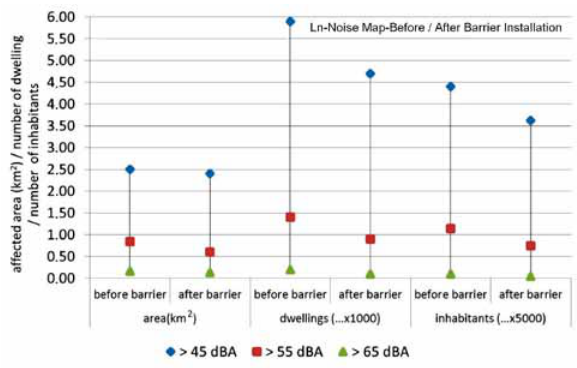
Fig. 10. Changes in numbers of affected area-dwellings- habitants in the night (L ) time interval with the addition of n noise barriers to the model. (e.g. number of dwellings exposed to noise before barrier over 55 dBA is calculated approx. by 1.4*1000 =